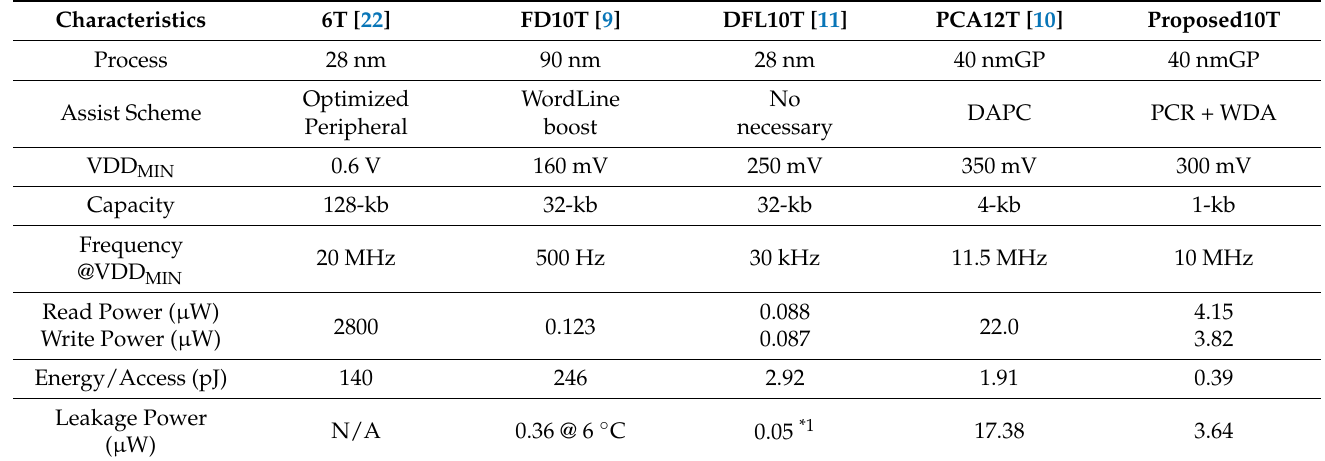
Table 2. The SRAM characteristics comparison